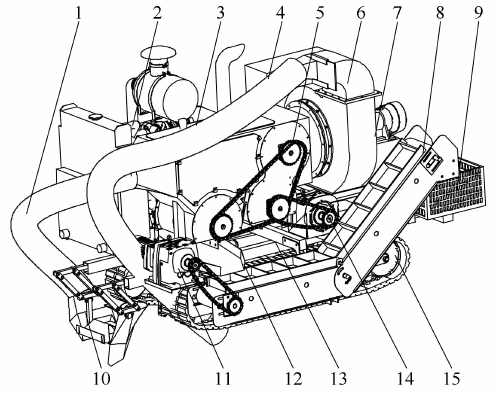
Figure 1. Structure of the positive and negative synergistic airflow-type jujube fruit harvester (P-N JH). 1. negative pressure airflow pipe; 2. diesel engine power generation system; 3. positive pressure